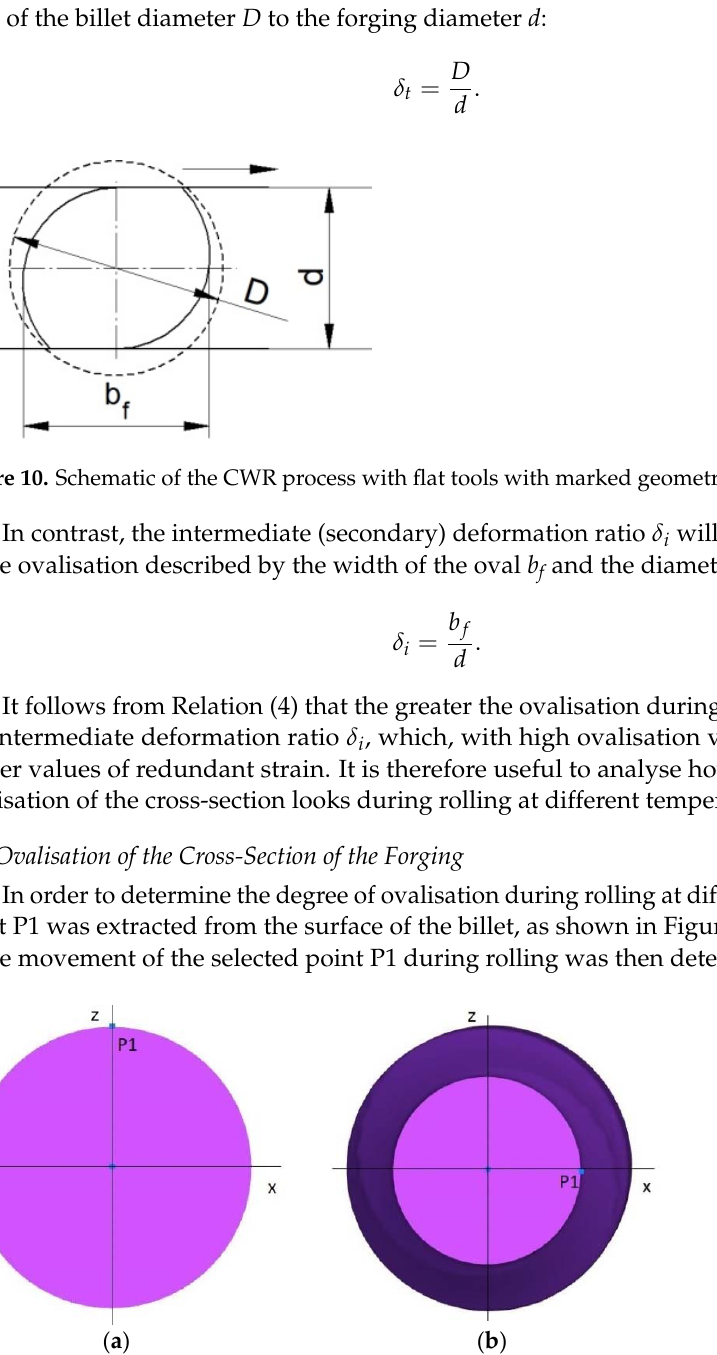
Figure 11. Location of point P1: ( a ) initial position on the surface of the billet; ( b ) final position on the surface of the forging.